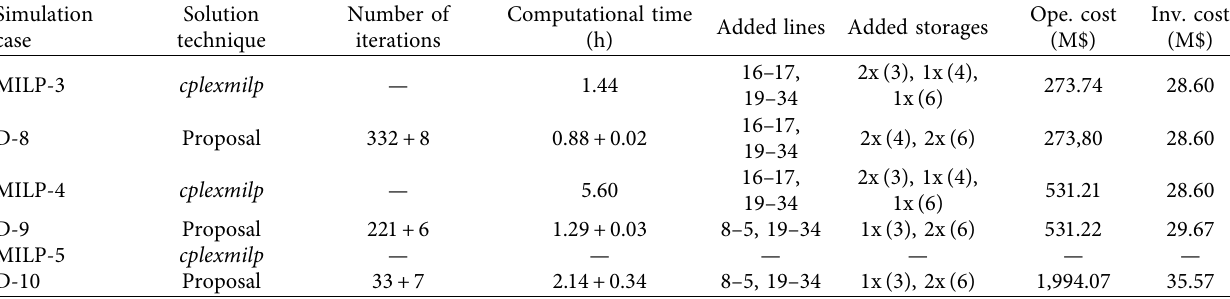
Table 4: Simulation results for the 118-bus modified IEEE-118 test